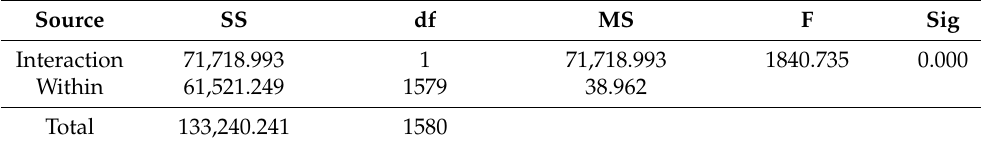
Table A1. One-way ANOVA on average thresdhold level per block.